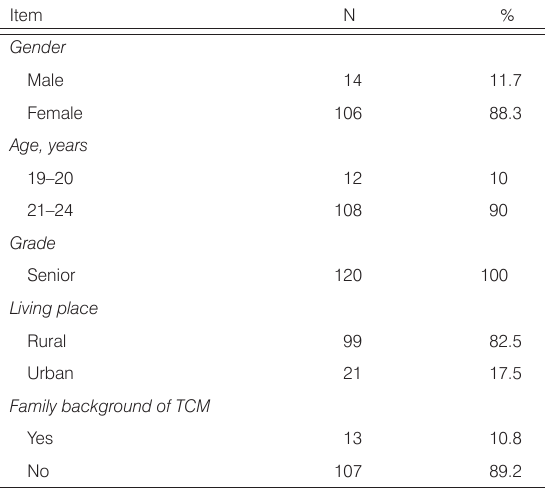
Table 1. Demographic characteristics of participants ( N =